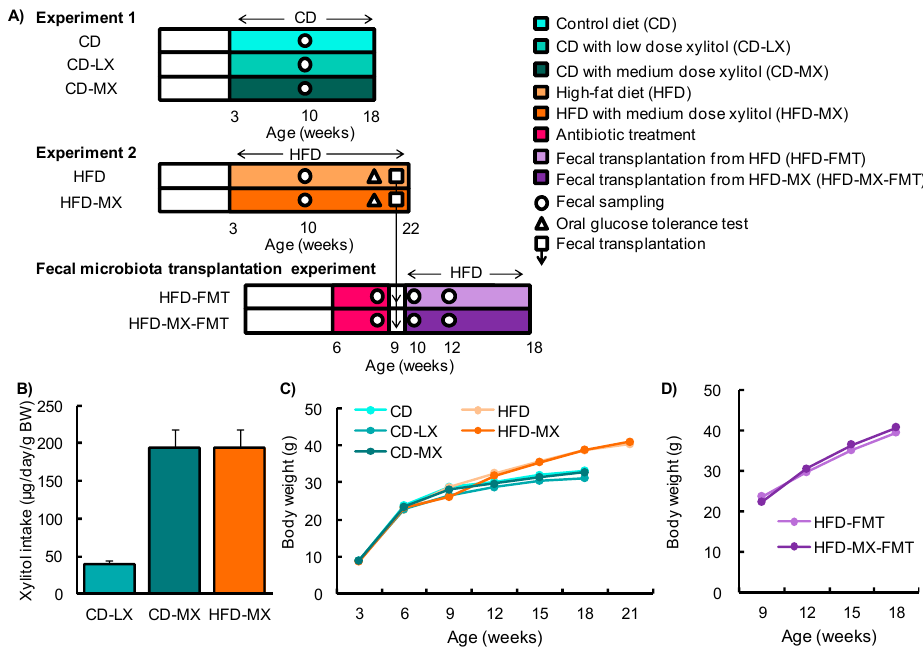
Figure 1. Experimental design and changes in body weight in mice fed xylitol. Study design for experiment 1 and 2 and the fecal transplantation experiment ( A ). Xylitol consumption during experiments ( B ). Changes in body weight (BW) throughout experiment 1 and 2 ( C ) and during the fecal transplantation experiment ( D ). Data represent the mean ± SEM ( n = 5–6).